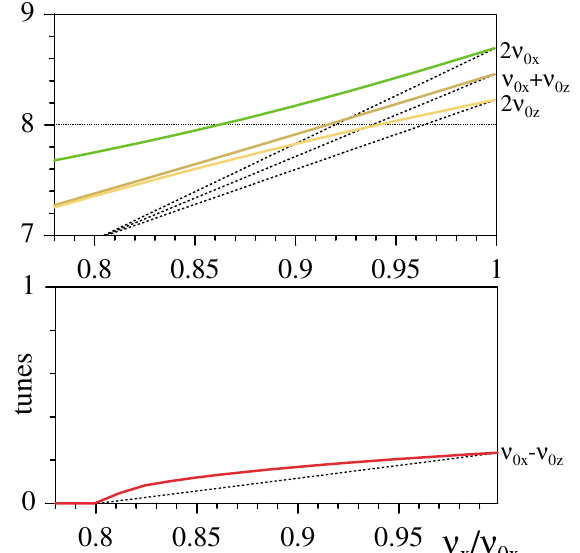
FIG. 1. (Color) Analytic results for second order coherent and incoherent (dashed lines) frequencies with (cid:19) (cid:3) 4 : 115 ; (cid:10) (cid:3) 4 : 35 . chine tunes (cid:10) 0 z 0 x